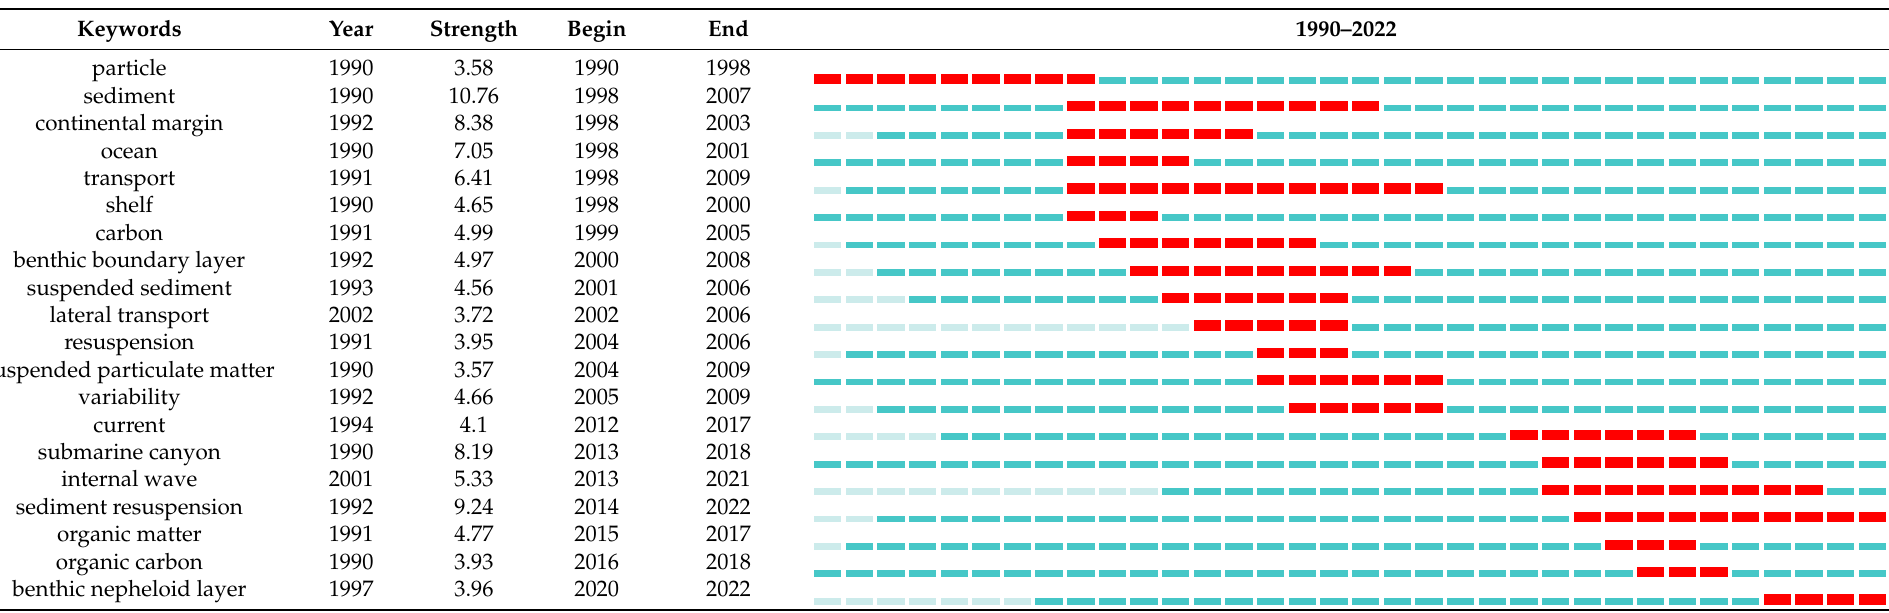
Table 5. Top 20 keywords with the strongest citation bursts. The strength reflects how many times the keyword occurs more frequently than other words.